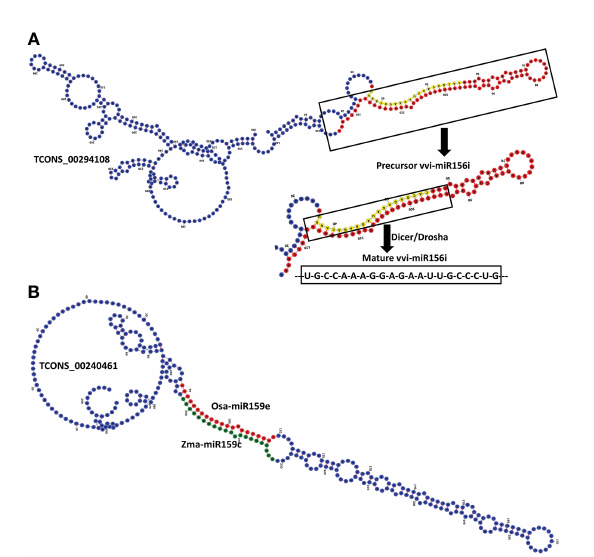
FIGURE 4 Black pepper circRNA/lncRNA shown chromosome wise. Outermost (dark blue) circle represents the black pepper circRNA, green circle represents intergenic lncRNAs, red circle represents intronic lncRNAs, and inner light blue circle represents antisense lncRNAs.